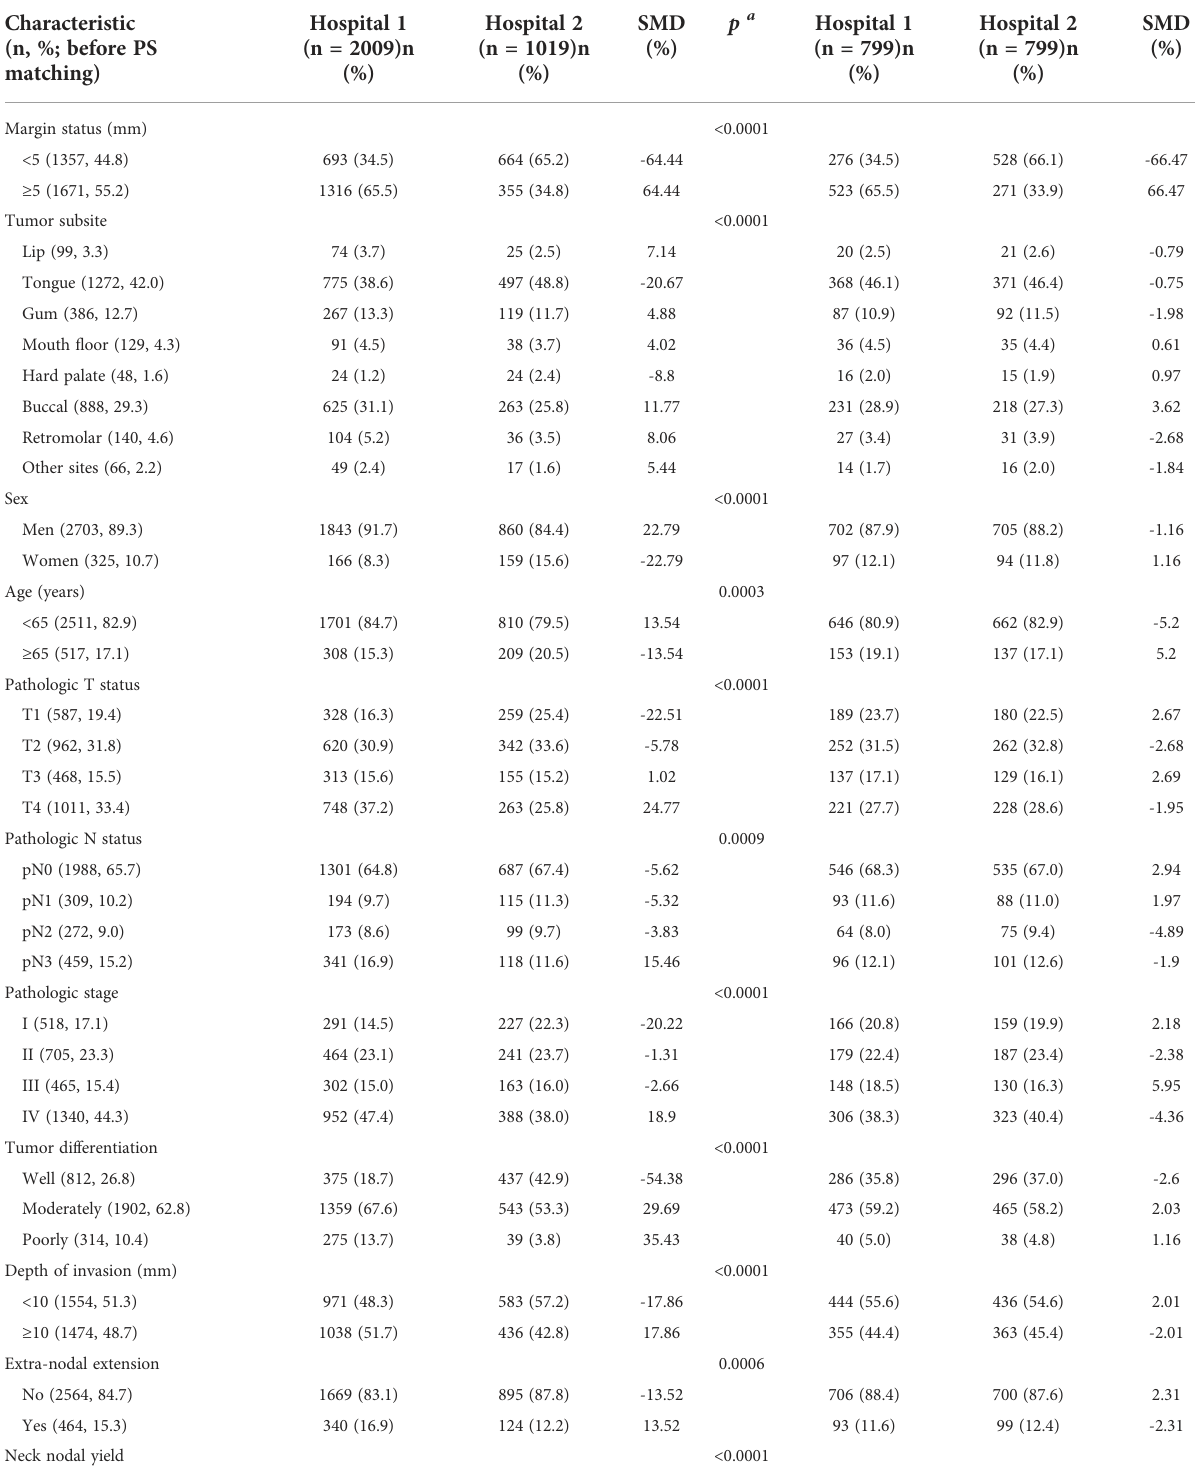
TABLE 1 General characteristics of patients with oral cavity squamous cell carcinoma enrolled from Hospital 1 and Hospital 2 before (n = 3028) and after (n = 1598) propensity score matching. Before PS matching After PS